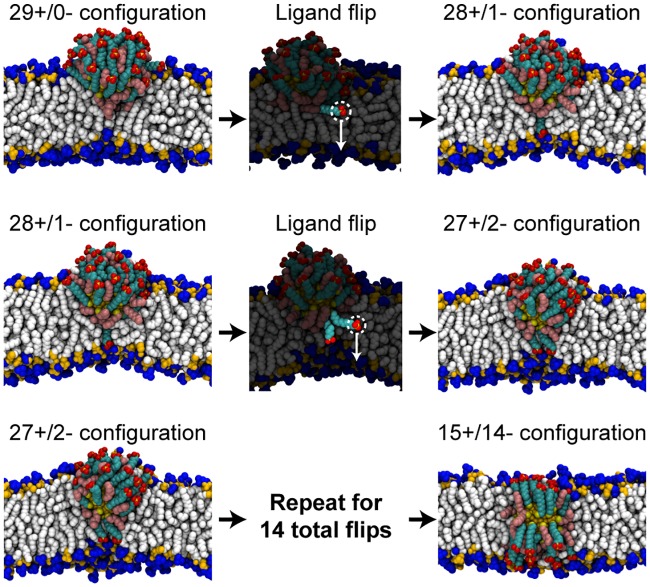
Workflow for flipping charged MUS ligands across a lipid bilayer.The initial configuration (taken from previous work [29]) has 29 MUS ligands positioned above the bilayer midplane and 0 MUS ligands below the midplane (29+/0-). A single MUS ligand (highlighted) is then flipped across the bilayer by applying a biasing potential to obtain the 28+/1- configuration. Water molecules and ions are included in the simulations but are omitted from the snapshots. MUS ligands are then iteratively flipped to generate different distributions of MUS end groups ranging from 29+/0- to 15+/14-. Additional details on this process are included in S1 Text.